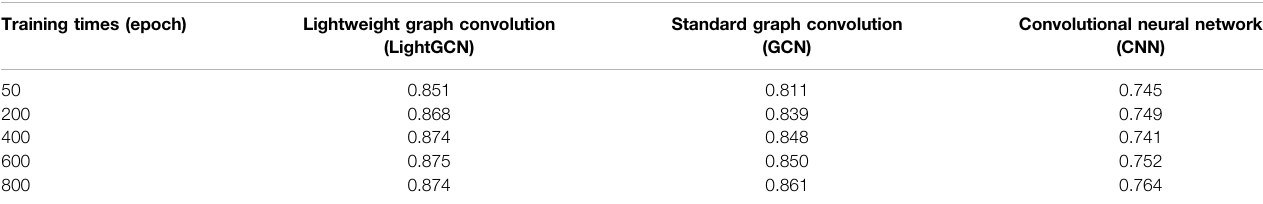
TABLE 3 | Recall rate